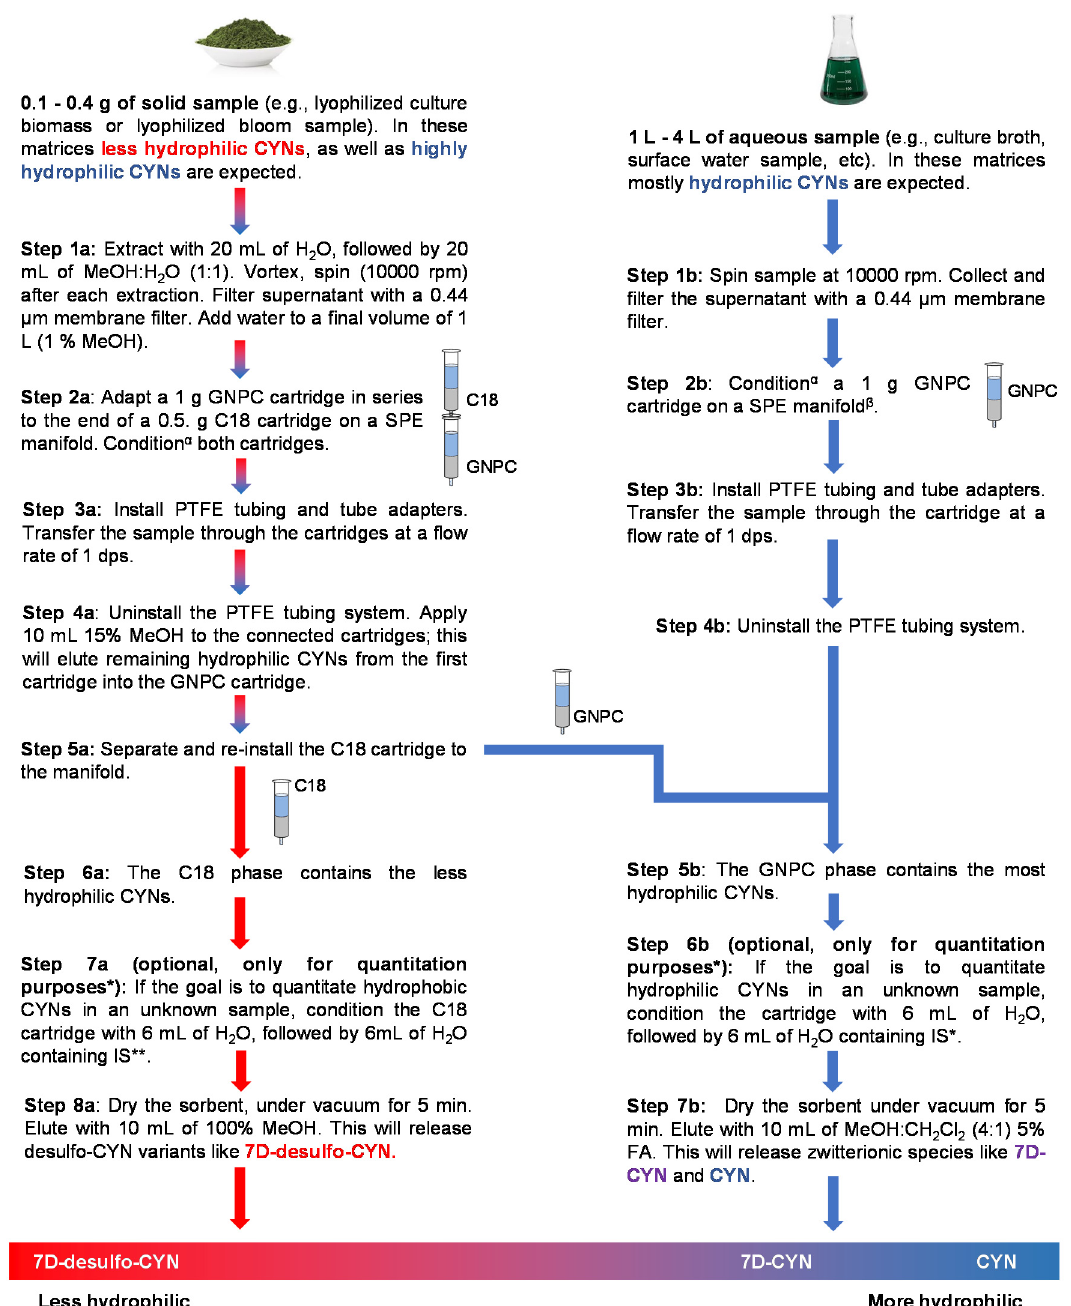
Figure 2. Proposed workflow for the simultaneous purification of zwitterionic (more hydrophilic) and desulfo (less hydrophilic) cylindrospermopsin analogs from cyanobacteria biomass, culture broth or surface water samples. MeOH: methanol, SPE: solid-phase extraction, GNPC: graphitized nonporous carbon, PTFE: polytetrafluoroethylene, IS: internal standard, CH 2 Cl 2 : dichloromethane, FA: